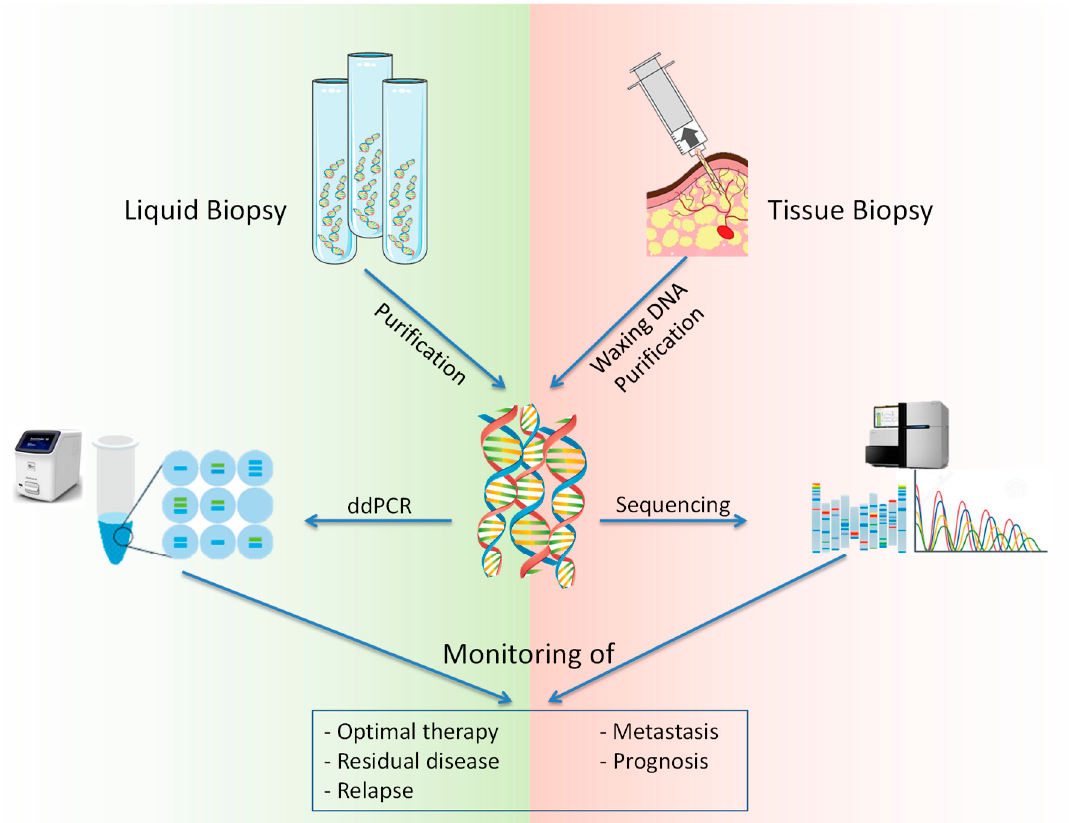
Figure 2. Comparison between liquid biopsy and tissue biopsy. The purification and/or extraction of DNA from liquid or tissue biopsy allows the researcher to perform high-throughput molecular analysis (Next Generation Sequencing or droplet digital PCR) in order to obtain significant data to define the prognosis of patients, to monitor the therapeutic efficacy and to predict the development of metastasis and relapse. Therefore, similarly to tissue biopsy, liquid biopsy allows the clinicians to obtain informative clinical data with a less invasive and less expensive method.